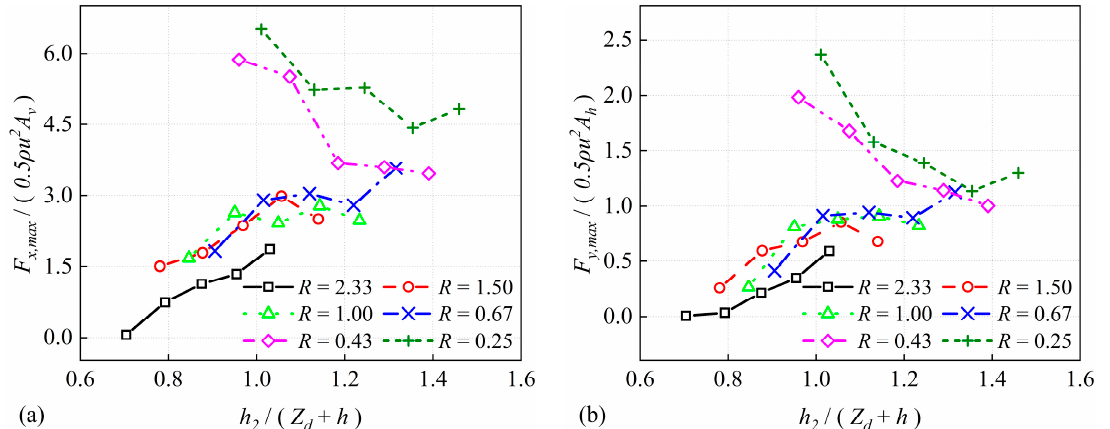
Figure 14. Normalized maximum tsunami forces at di ff erent relative wave heights: ( a ) horizontal tsunami force; ( b ) vertical tsunami force ( Z d = 0.2 m).